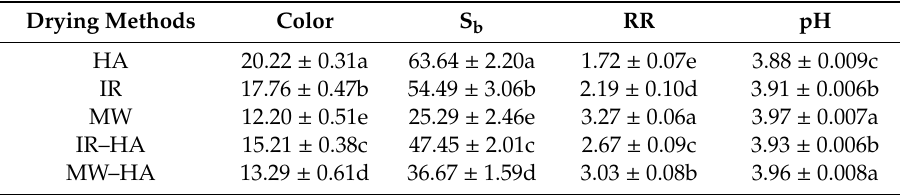
Table 7. The results of color, S b , RR, and